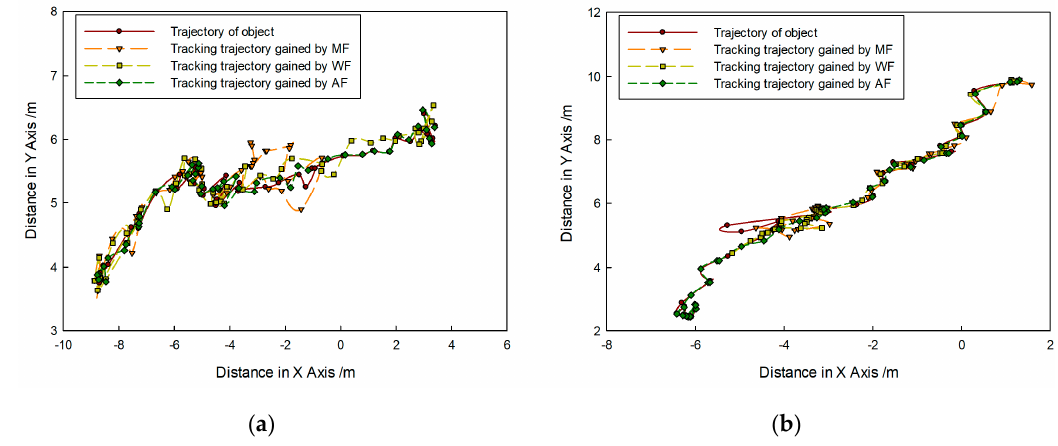
Figure 18. Tracking trajectory gained by different fusion methods of ( a ) first target and ( b ) second target.